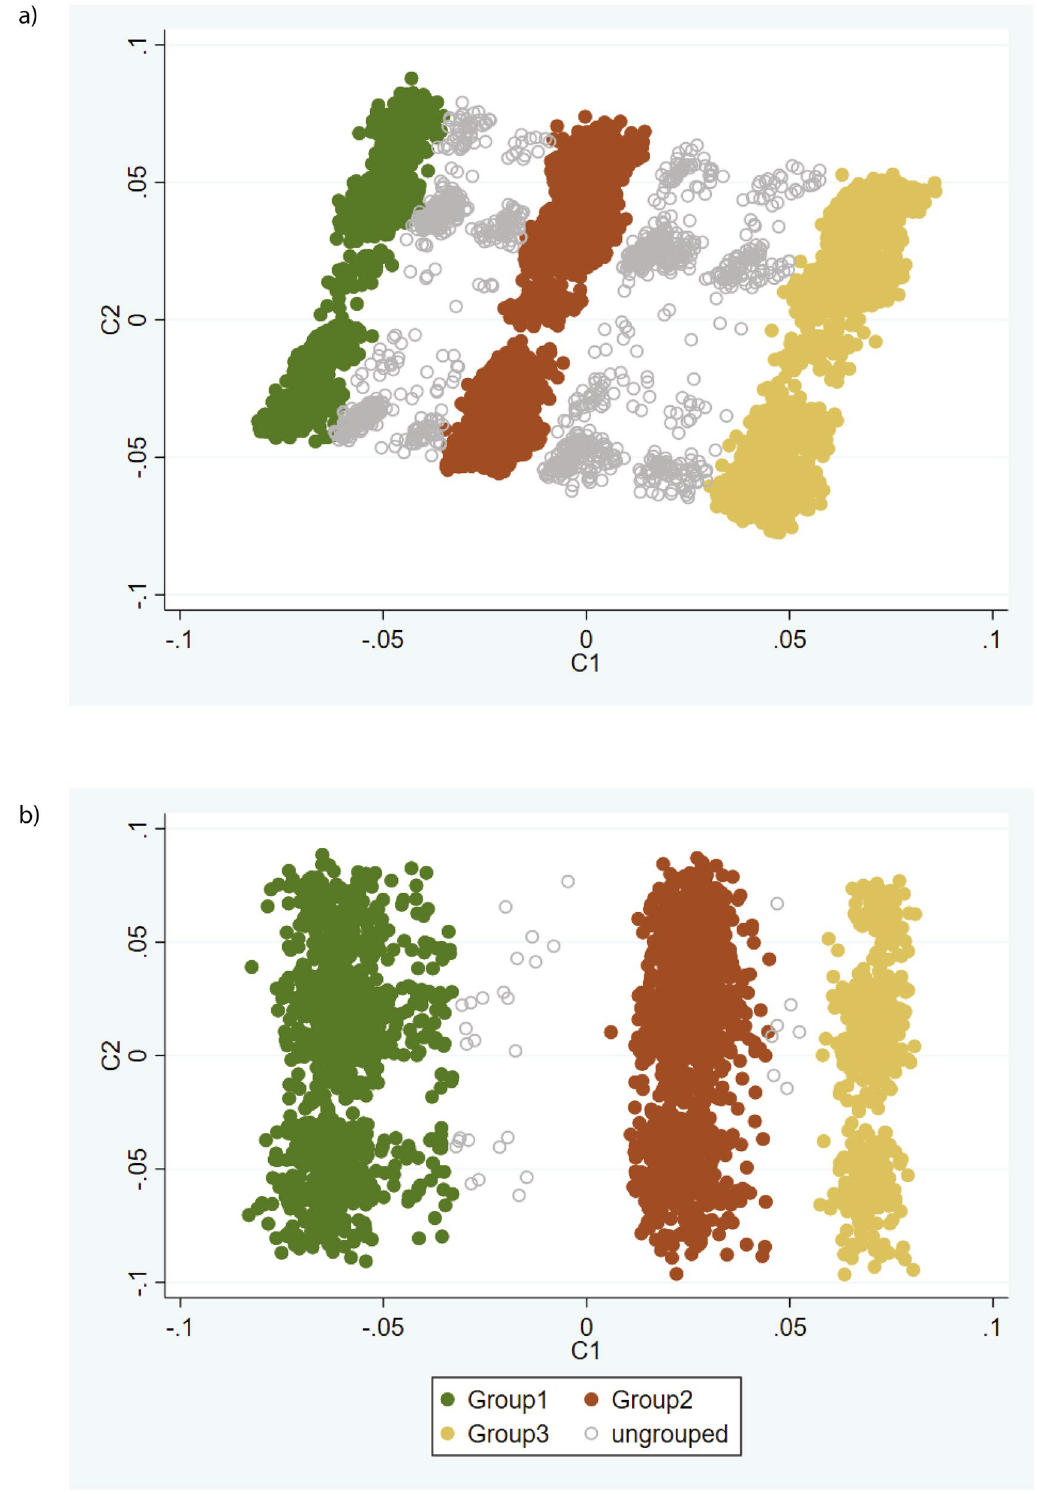
Figure 5. Comparison of the three clusters identified in UKB2 in individuals ( a ) without and ( b ) with mental illness. Each data point is an individual therefore the individuals who are closer together are more genetically